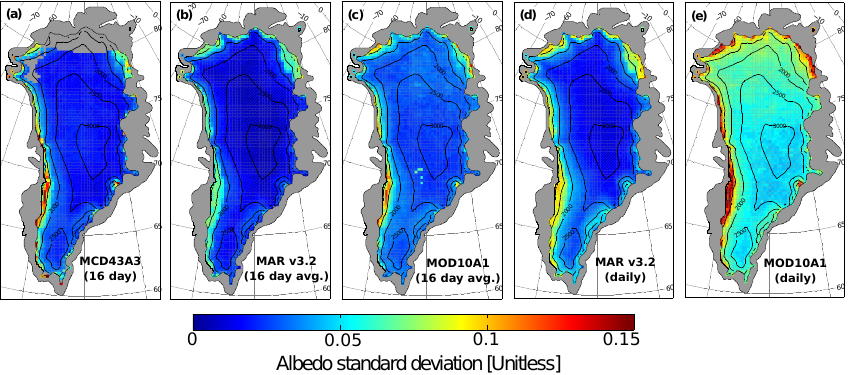
Figure 7. Standard deviation of JJA albedo (unitless) (2000–2013) for (a) MCD43A3 SW BSA (b) MAR v3.2 clear-sky 16-day averages (c) MOD10A1 16-day averages (d) MAR v3.2 clear-sky daily, and (e) MOD10A1 daily.